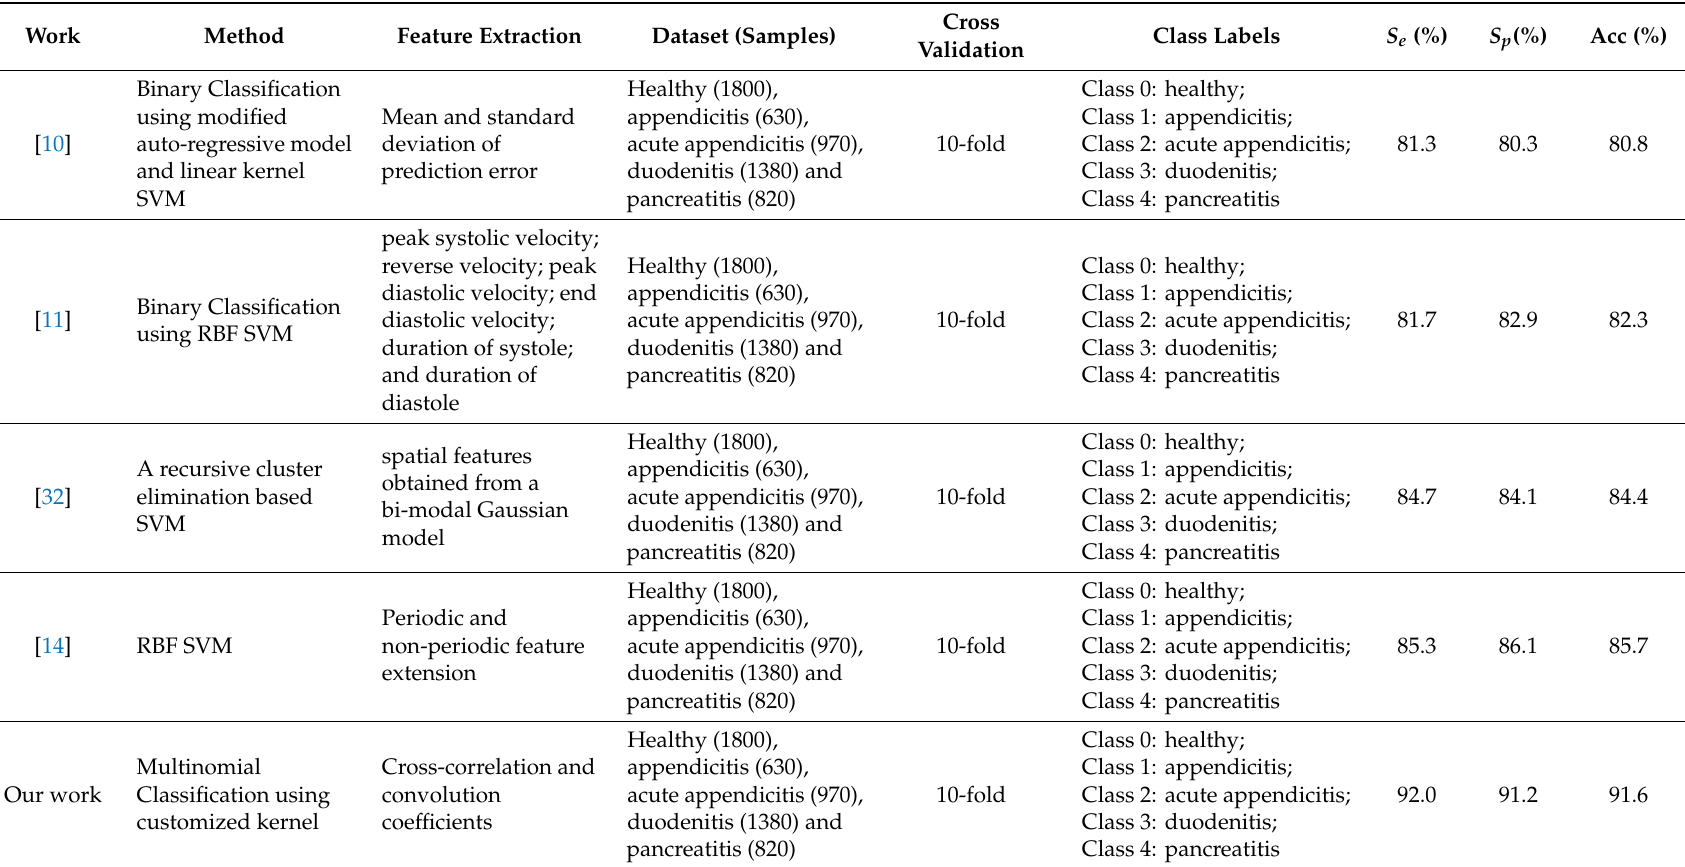
Table 5. Matched comparison between proposed and related work